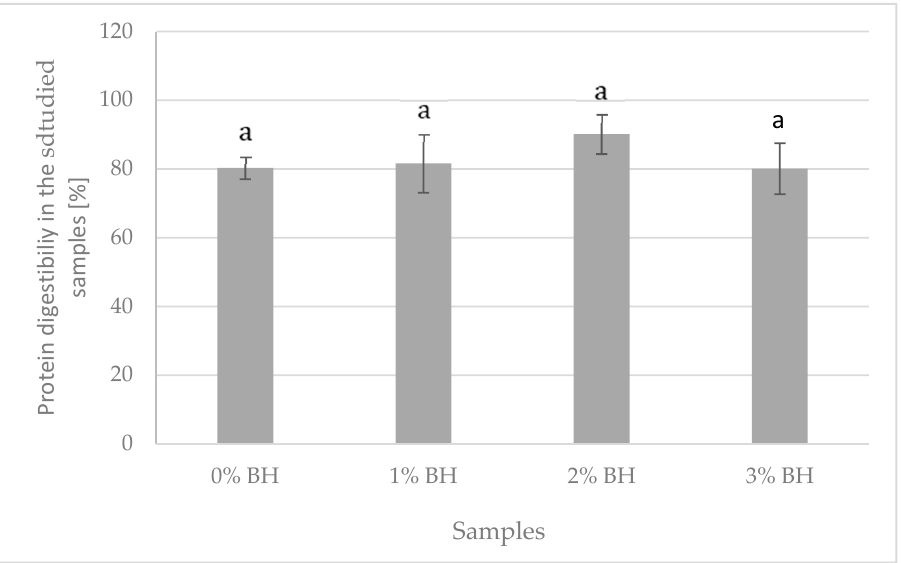
Figure 2. Effect of BH on protein digestibility in the studied samples. a—same letters indicate no significant differences ( p ≤ 0.05) between values.